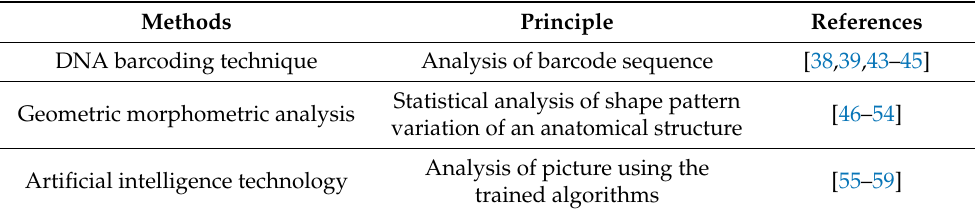
Table 2. Recent advanced tools for diagnosis of medical parasites and arthropods.